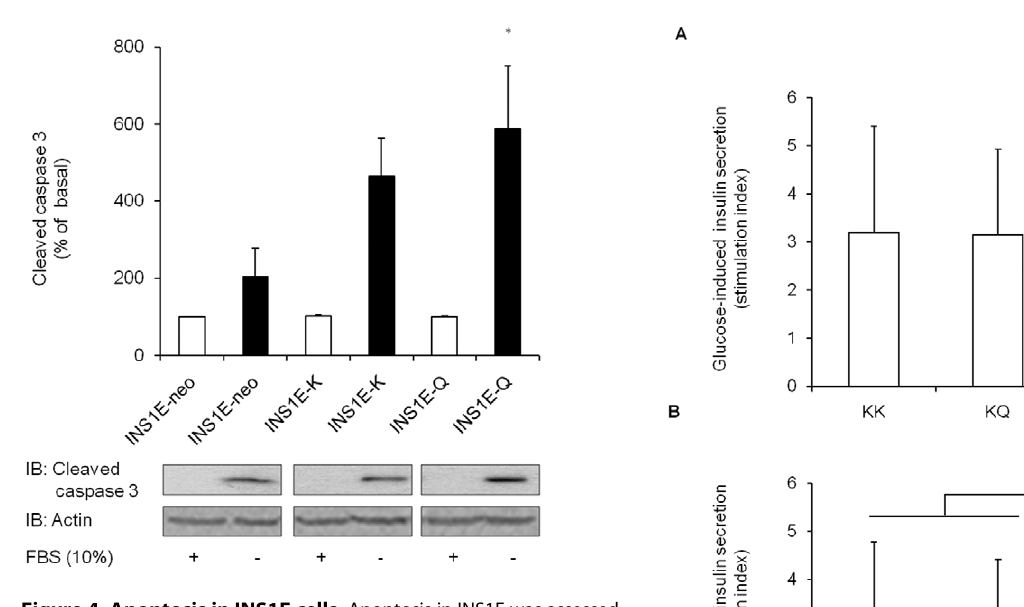
Figure 4. Apoptosis in INS1E cells. Apoptosis in INS1E was assessed by determining cleaved caspase-3 expression by Western blot. Equal amount of protein from cell lysates was separated by SDS-PAGE and probed with specific antibody. Bars (upper panel) represent quantita- tive analysis of cleaved caspase-3 calculated as percentage of that of non serum deficient control cells for each experiment (mean 6 SEM), while representative immunoblot from the same experiment is shown in lower panel. A significant increment in cleaved caspase-3 expression was observed in INS1E-Q cells as compared to INS1E-neo control cells (*p , 0.05, n=4 experiments in separate times). When properly tested, a progressive increase was observed from INS1E-neo to INS1E-K and then INS1E-Q cells (p for trend=0.038). Figure 5. Insulin secretion in isolated human islets from 85